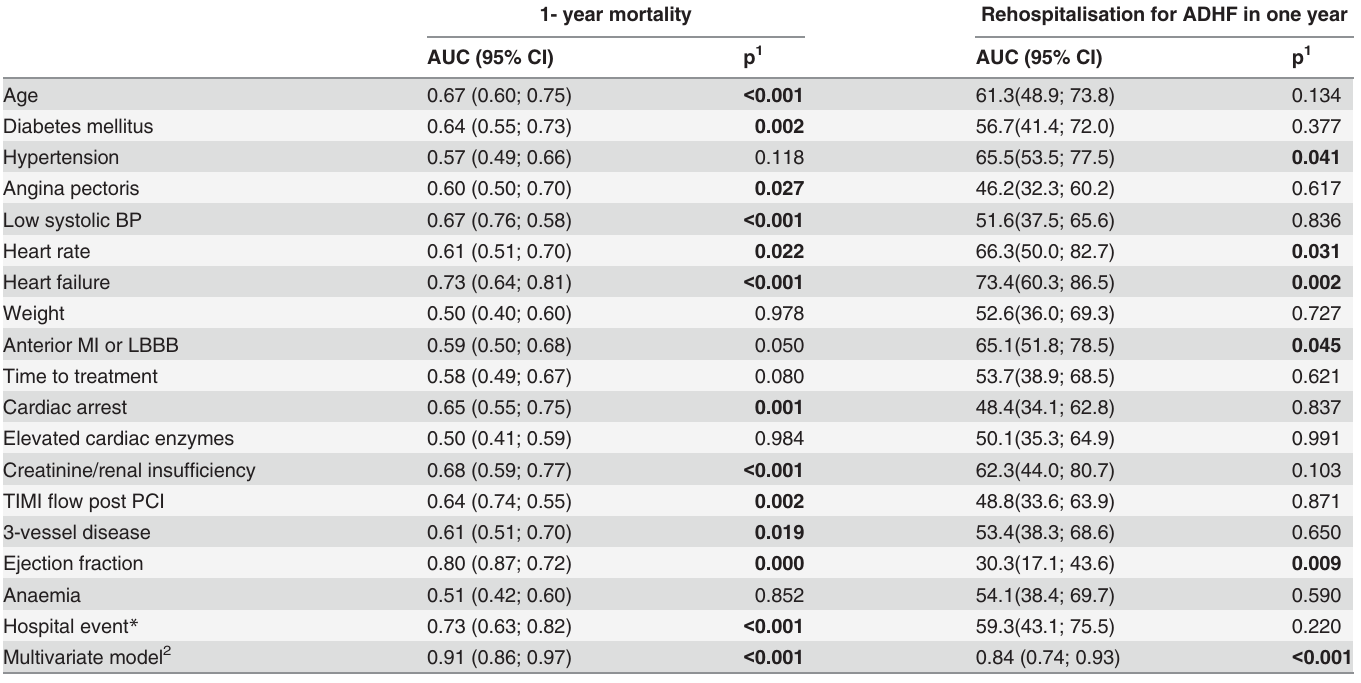
Table 6. Univariate and multivariate analysis of predictive ability for the components of given scores for prediction of 1-year mortality and one- year risk of rehospitalisation for ADHF.